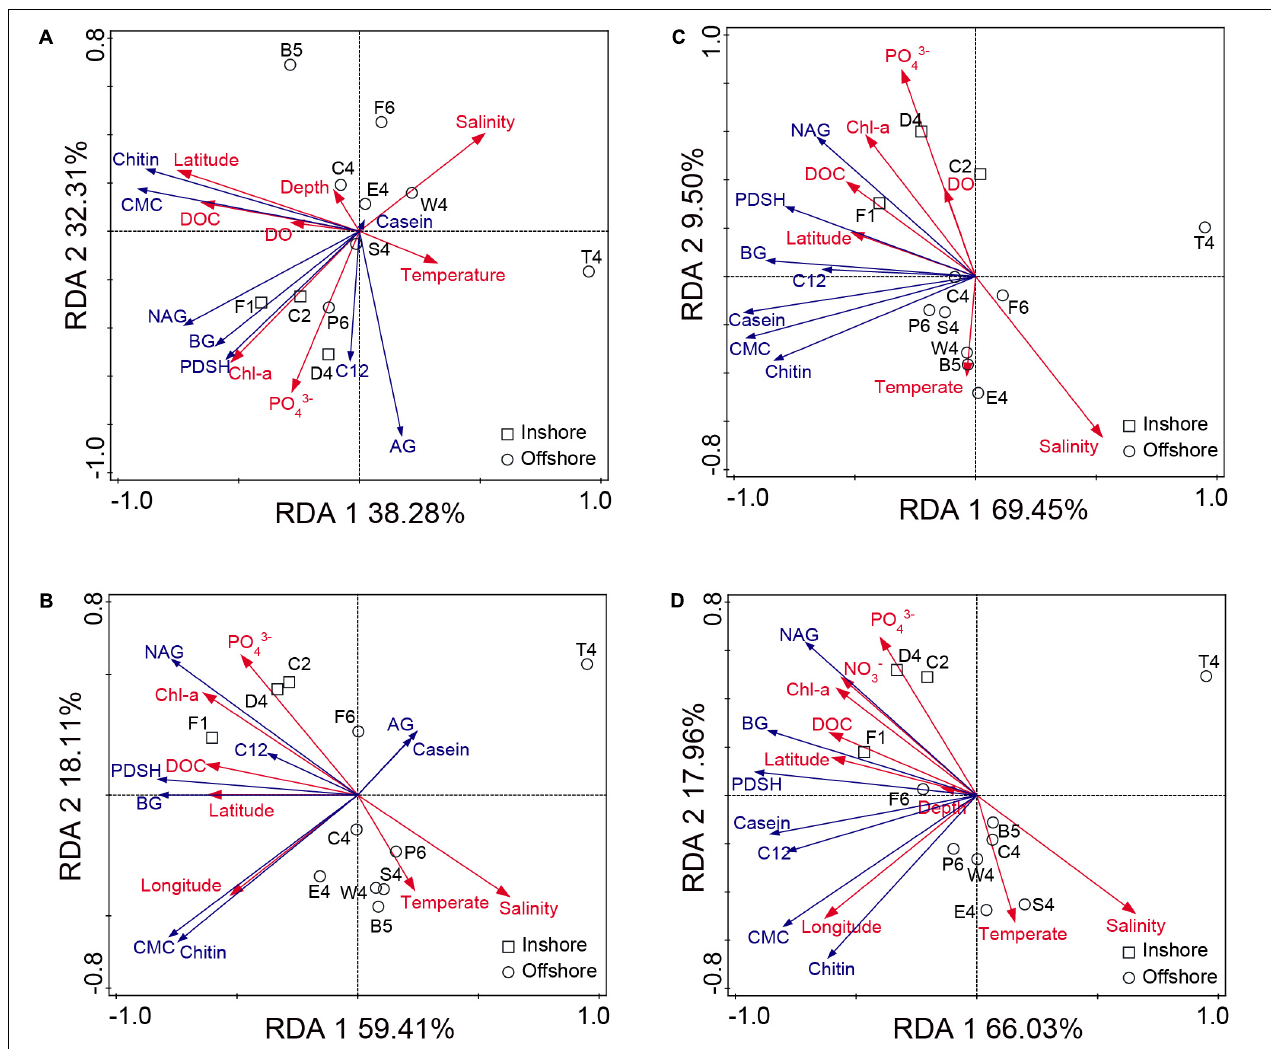
FIGURE 6 | Redundancy analyses (RDA) between environmental parameters and EEAs. (A) The total enzyme activities at 35 ◦ C. (B) The dissolved enzyme activities at 35 ◦ C. (C) The total enzyme activities at 25 ◦ C. (D) The dissolved enzyme activities at 25 ◦